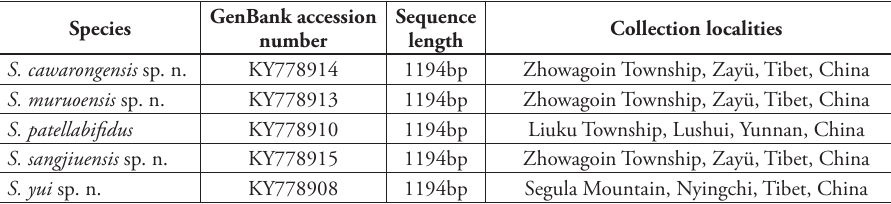
Table 1. Voucher specimen